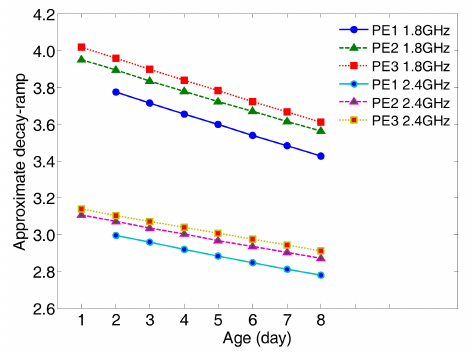
Figure 6. Approximate decay-ramp functions of Equation (2a,b) at 1.8 GHz and 2.4